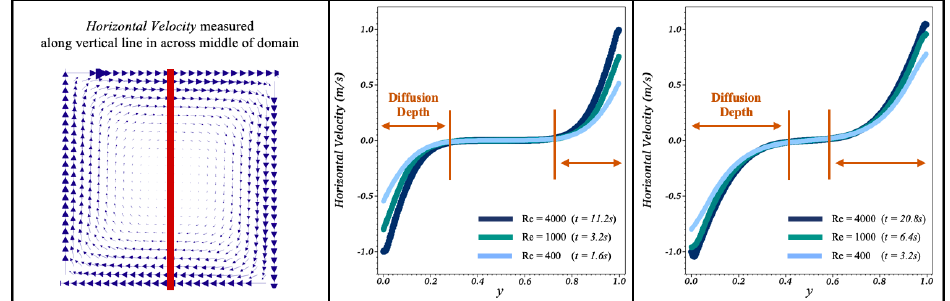
Figure 28. Snapshots showing horizontal velocity measurements across a vertical line centered in the domain among cases for Re = 400,1000, and 4000 in which similar momentum diffusion depths have been reached.